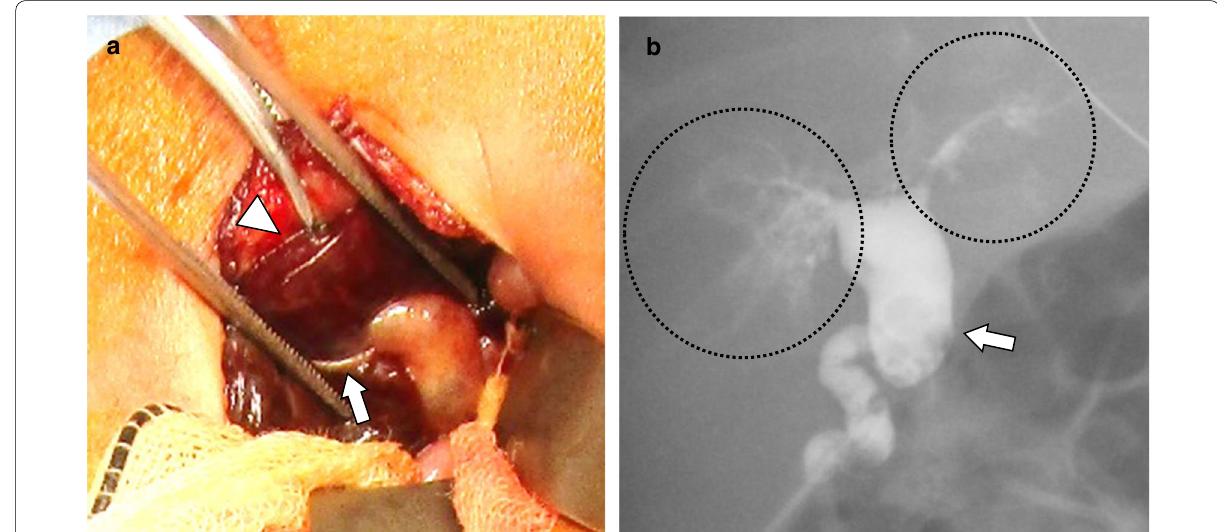
Fig. 2 Intraoperative findings at 58 days of age (exploratory laparotomy and cholangiography). a The liver (arrowhead) was still soft. A drainage tube (arrow) was placed in the gallbladder. b Cholangiography revealed a cystic common bile duct (arrow) that had no communication with the duodenum and a cloudy pattern of intrahepatic ductules